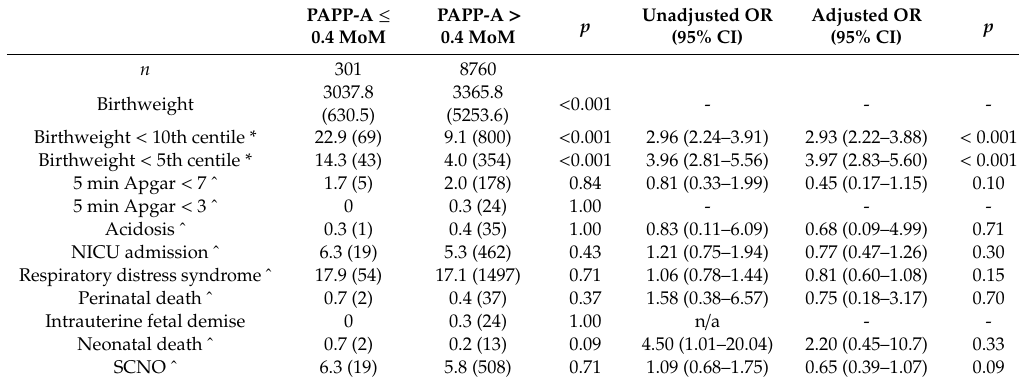
Table 3. Perinatal